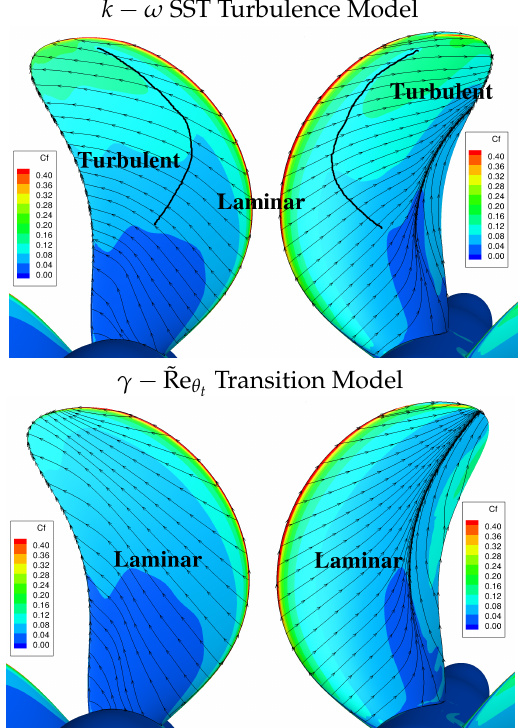
Figure 15. Limiting streamlines and skin friction coefficient using the k − ω SST turbulence model ( top ) and γ − ˜Re θ transition model ( bottom ) at Re = 1 × 10 5 for J = 0.568. Pressure side ( left ) and t suction side ( right ).